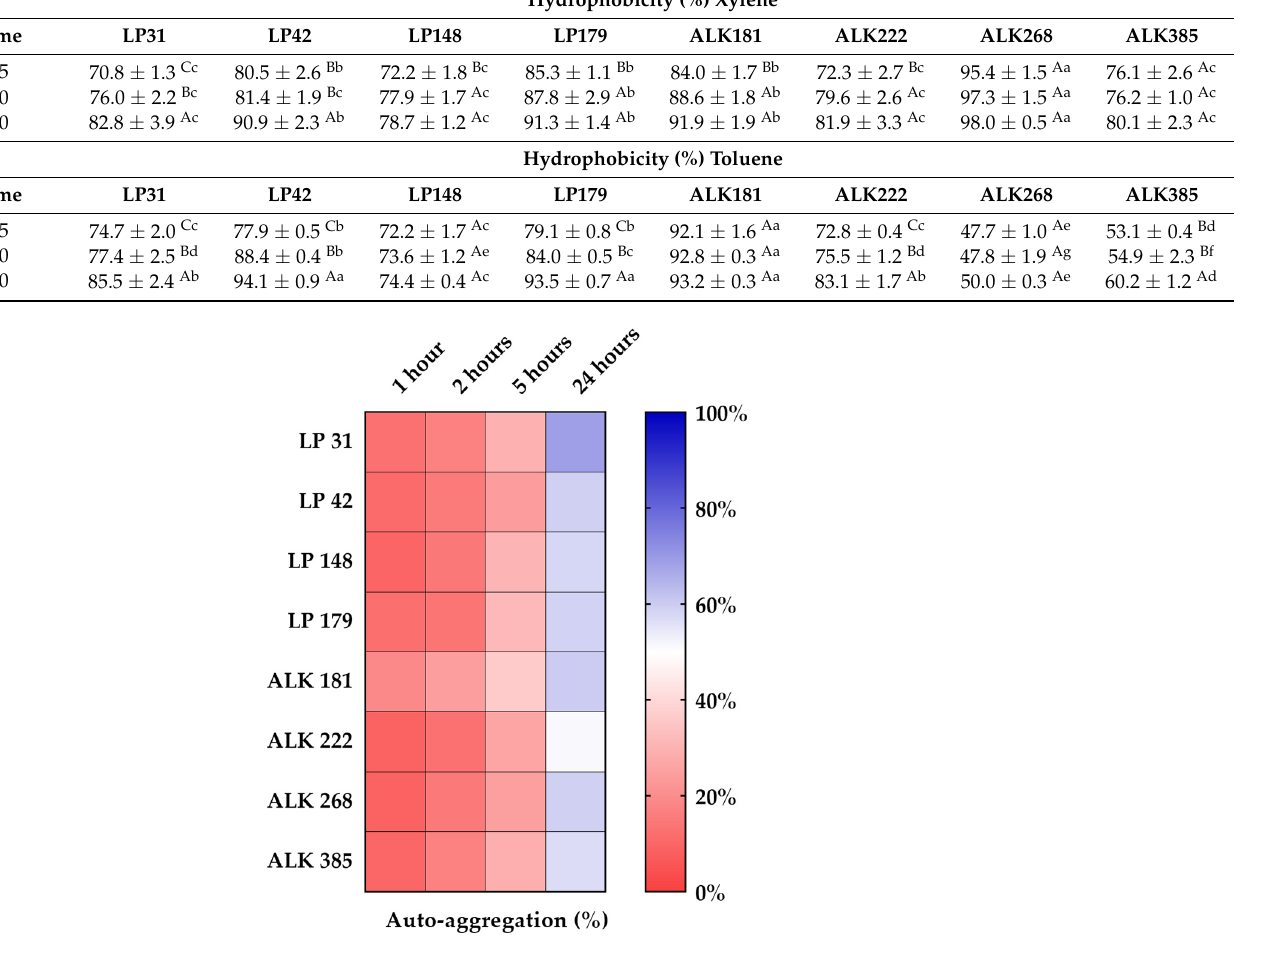
Figure 3. Percentage of auto-aggregation (AA%) of the Lactiplantibacillus plantarum and Apilactobacillus kunkeei strains. Table 3. Auto-aggregation (AA) at 35 ◦ C of the tested lactic acid bacteria ( Lactiplantibacillus plantarum : LP 31, LP 42, LP 148 and LP 179; Apilactobacillus kunkeei : ALK 181, ALK 222, ALK 268 and ALK 385). The data (mean ± SD; n = 3) were expressed as percentage of AA, different lowercase letters in each row and uppercase letters in each column indicate significant differences ( p <